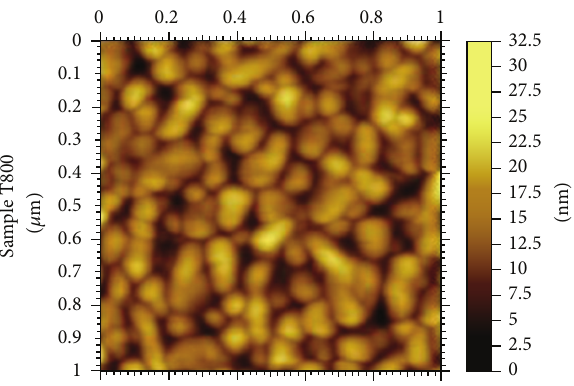
Figure 7: AFM topography images for all TiO 2 films. Scan area is 1 𝜇 m × 1 𝜇